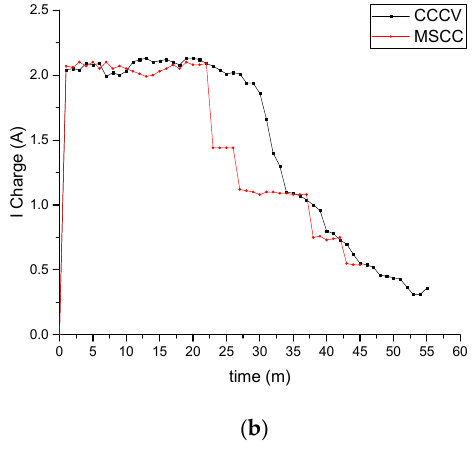
Figure 12. Charging current: ( a ) 2S; ( b )